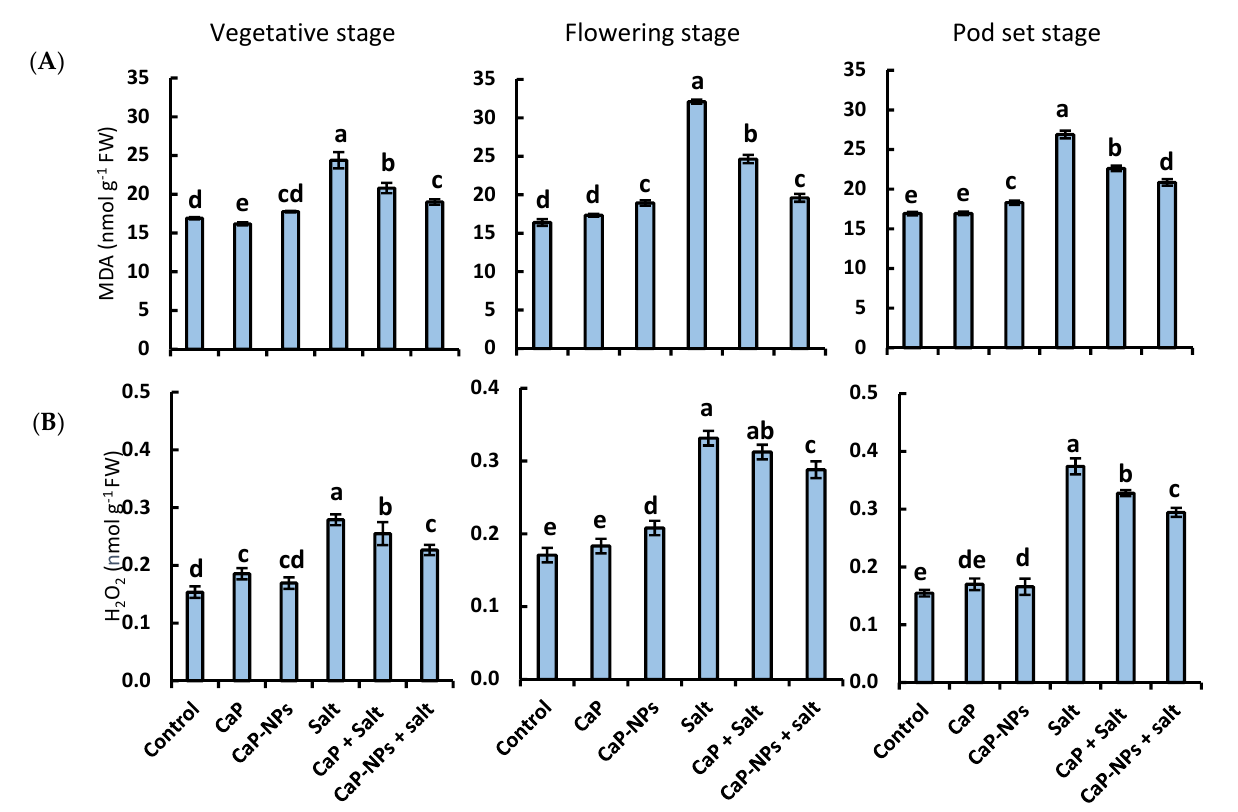
Figure 8. Effect of different treatments on ( A ) MDA and ( B ) H 2 O 2 of broad bean plants in 3 growth stages. The same letters indicate no significant difference ( p < 0.05) as analyzed by the Duncan test. Each value is the average of 3 replicates ± SE.